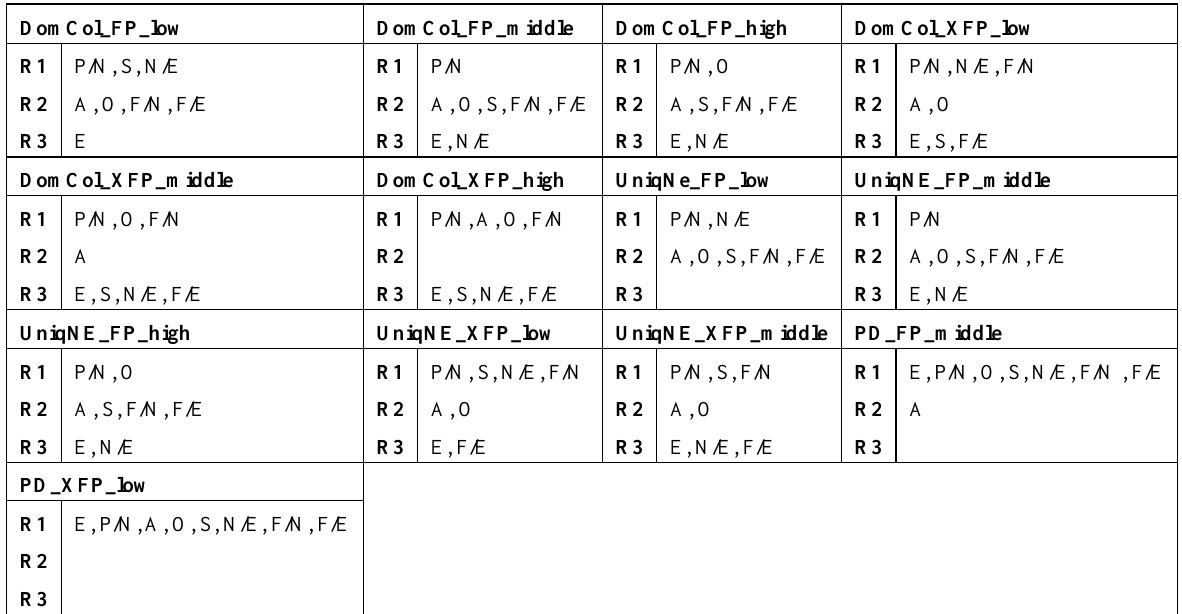
Table 6. Matrices used for the individual analysis, with each type’s choice specified.